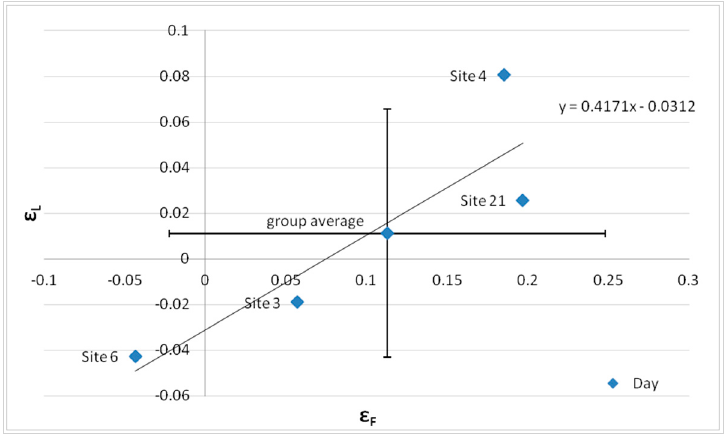
Figure 18. Relative mean hourly deviation between traffic noise measurements and the corresponding DYNAMAP predictions, ε L , versus the relative deviation between the logarithm of traffic flow measurements and the corresponding model calculations at the reference hour (8:00–9:00), ε F , for each site of group 3.